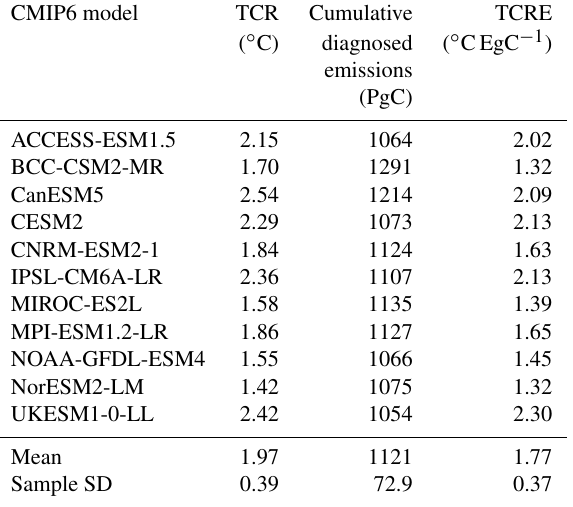
Table 4. Transient climate response (TCR; (cid:49)T 2 × CO cumulative emissions at 2 × CO 2 ( ˜ E 2 × CO response to cumulative emissions (TCRE) for the 11 CMIP6 models considered in this